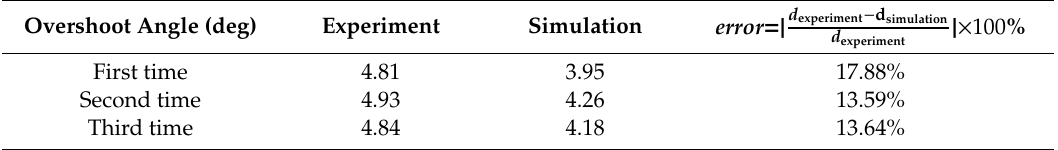
Table 4. Analysis of the overshoot angle of the +10 deg zig-zag test.